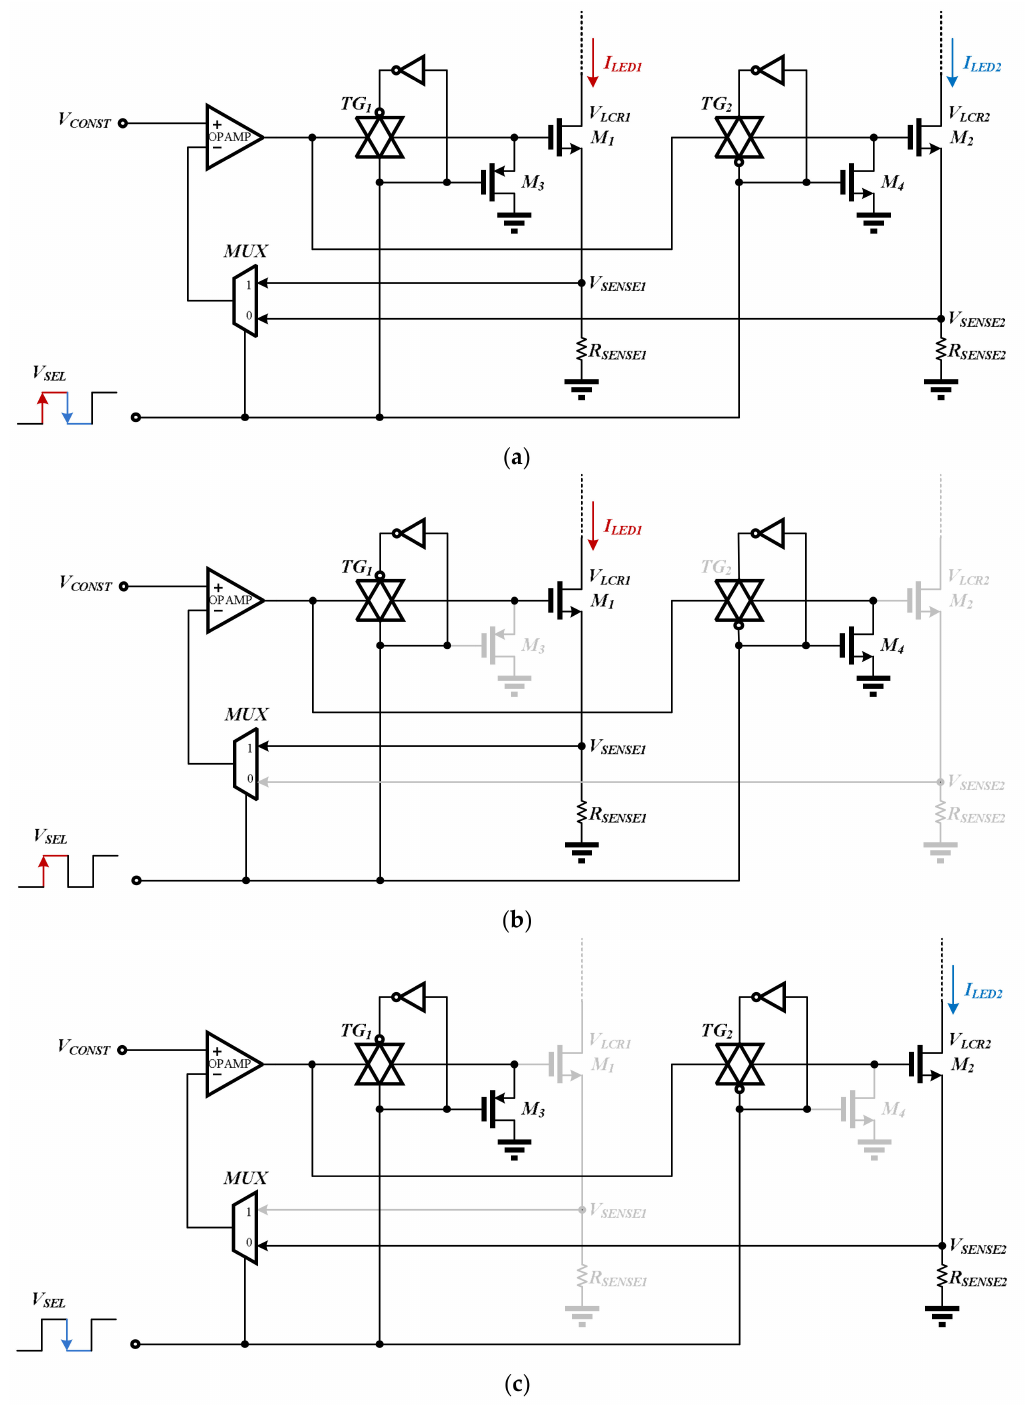
Figure 8. Proposed switching linear current regulator: ( a ) schematic; ( b ) driving current path of LED string1; ( c ) driving current path of LED